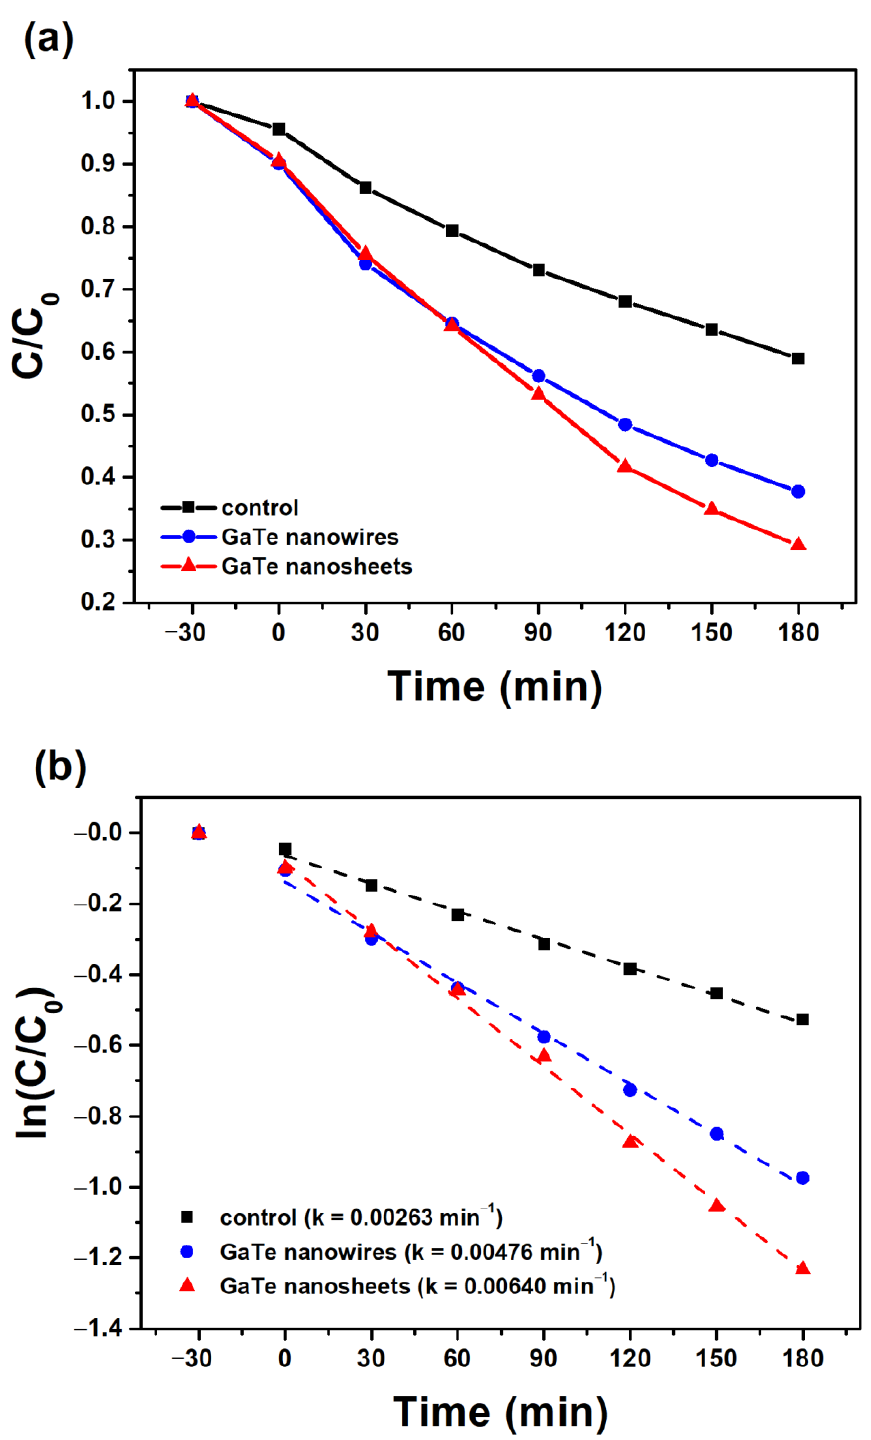
Figure 6. ( a ) Visible-light photocatalytic degradation of methyl blue (MB) solution of GaTe nanowires and nanosheets. ( b ) Visible-light photocatalytic rates of GaTe nanowires and nanosheets.